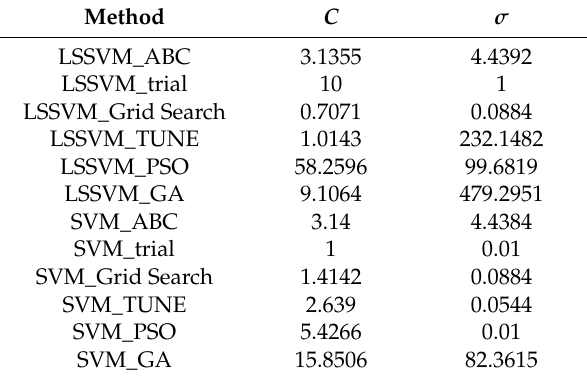
Table 4. Parameters used in various methods.